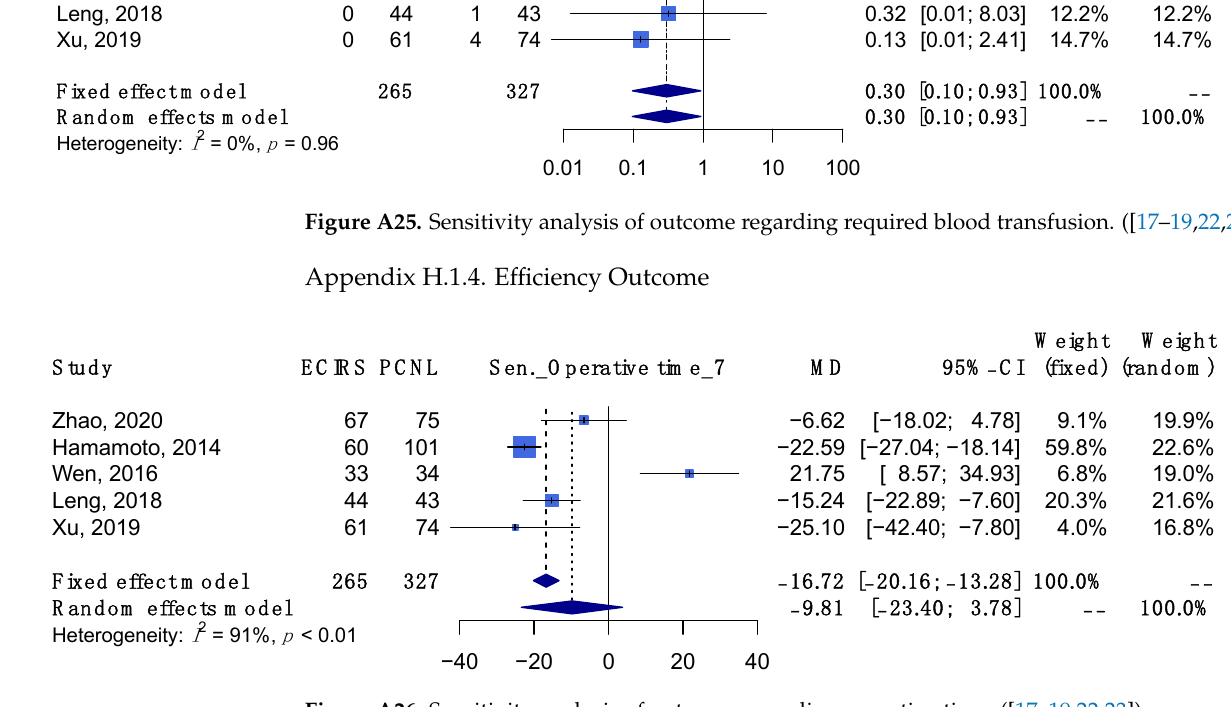
Figure A27. Sensitivity analysis of outcome regarding hospital stay. ([17–20,22,23]) Appendix H.2. Exclude NOS Lower than 8 Appendix H.2.1. Efficacy Outcome Figure A28. Sensitivity analysis of outcome regarding initial stone free rate. ([17–19,22]) Figure A29. Sensitivity analysis of outcome regarding final stone free rate. ([17,19,22])